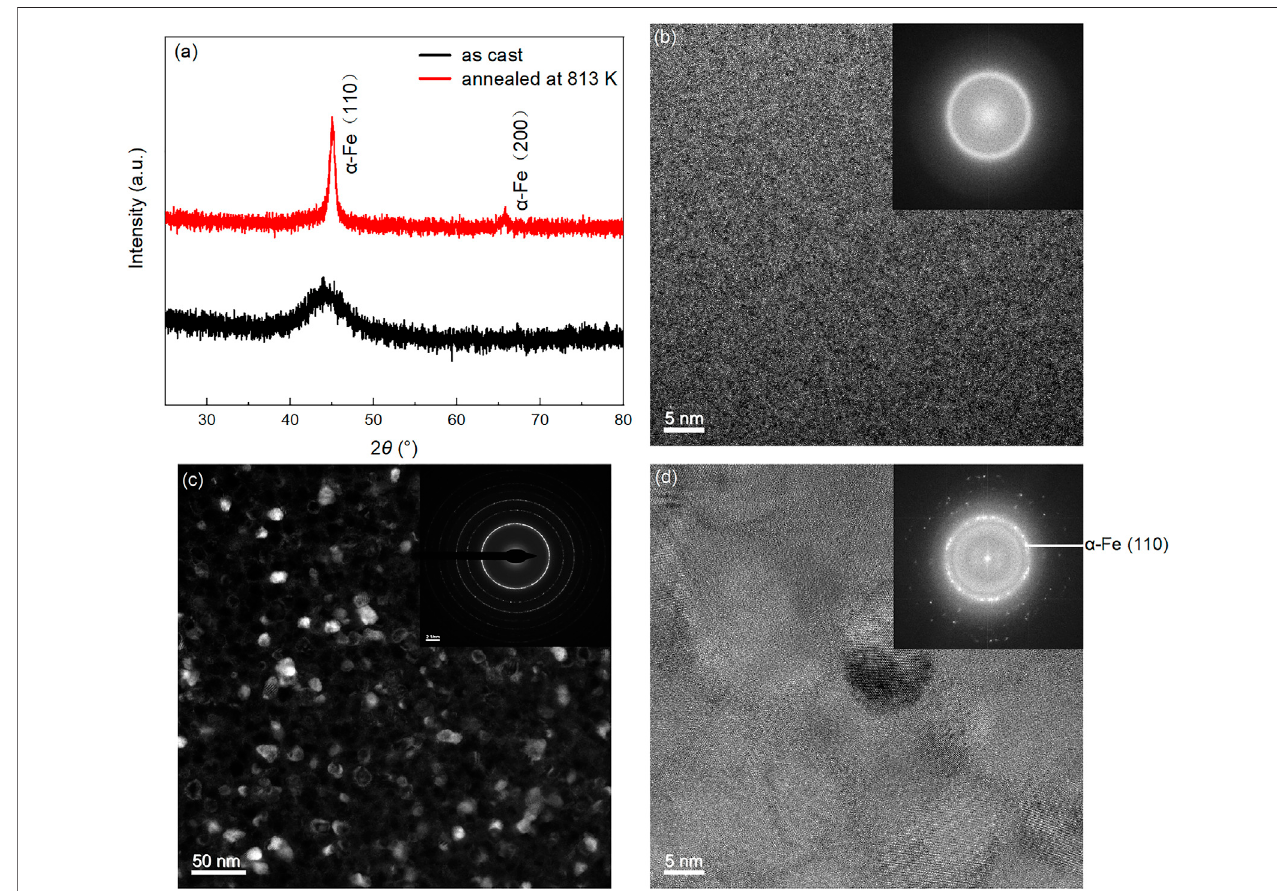
FIGURE 1 | (A) XRD patterns of the Fe 73.5 Cu 1 Nb 3 Si 13.5 B 9 ribbons in the as-cast state and after annealing at 813 K for 30 min in vacuum. (B) TEM micrograph of amorphous Fe 73.5 Cu 1 Nb 3 Si 13.5 B 9 ribbons. Inset: the associated fast Fourier transform (FFT) pattern. (C) – (D) TEM micrographs of the Fe 73.5 Cu 1 Nb 3 Si 13.5 B 9 ribbons annealed at 813 K for 30 min in vacuum at different magni fi cations. The selected area electron diffraction pattern and the associated fast Fourier transform (FFT) pattern are shown in the inset of (C) and (D) ,